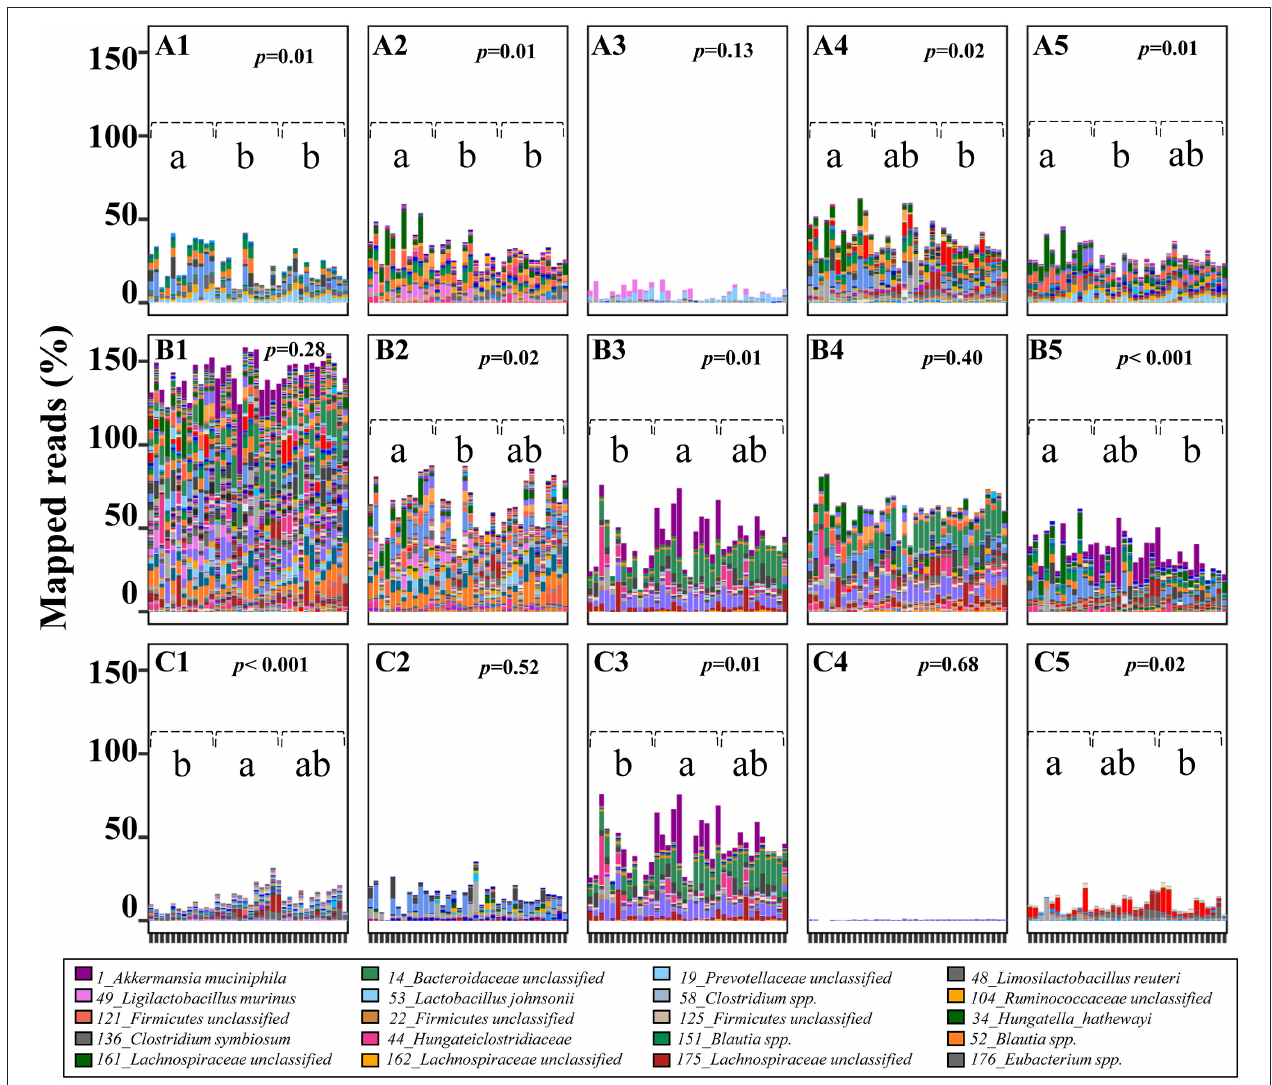
FIGURE 4 | Predicted potential of cecal microbiome involved in lactose and SCFA metabolism in 3-week old offspring. The potential of each cecal microbial community to degrade lactose and generate SCFA-related metabolites was calculated by the sum of mapped reads (%) for positive hits of the corresponding key enzymes as follow: Lactose (A1,A2) beta-galactosidase (LacZ and Lacdeb), (A3–A5) phospho- β -galactosidase (LacG, BbgI and LacM); Acetate (B1) acetate kinase (AK); Lactate (B2) D/L-lactate dehydrogenase (LacDeh); Succinate, (B3) fumarate reductase (frdA); 1,2-Propanediol; (B4) , lactaldehyde reductase (LacRd); Cobalamin (Vitamin B12), (B5) cobalt transporter protein (CbiM); Butyrate (C1) butyryl:acetate CoA-transferase (BCoA), (C2) butyrate kinase (BK); Propionate, (C3) methylmalonyl-CoA decarboxylase (McoA), (C4) lactoyl-CoA dehydratase (LacCoRd), (C5) propanediol dehydratase (pduCDE). Data with different superscripts represents significant difference ( p < 0.05). For bars in each panel, left to right: water control ( n = 6); aspartame ( n = 6) and stevia ( n = 6).